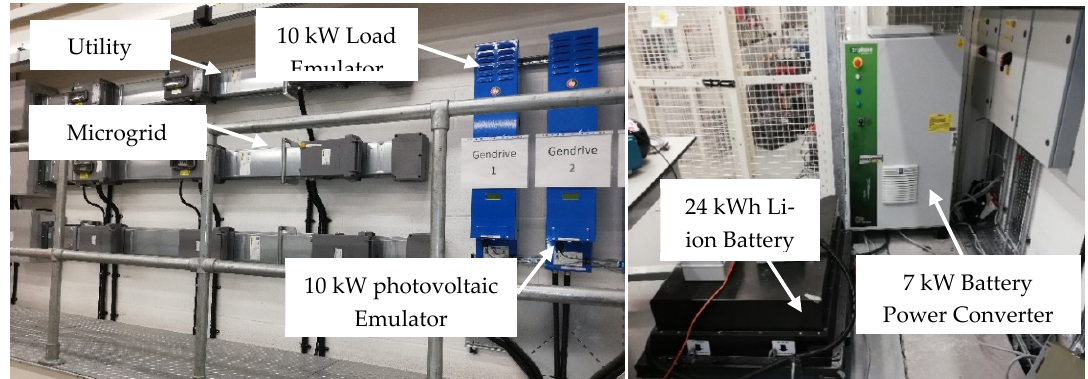
Figure 11. The microgrid at the University of Nottingham Laboratory.